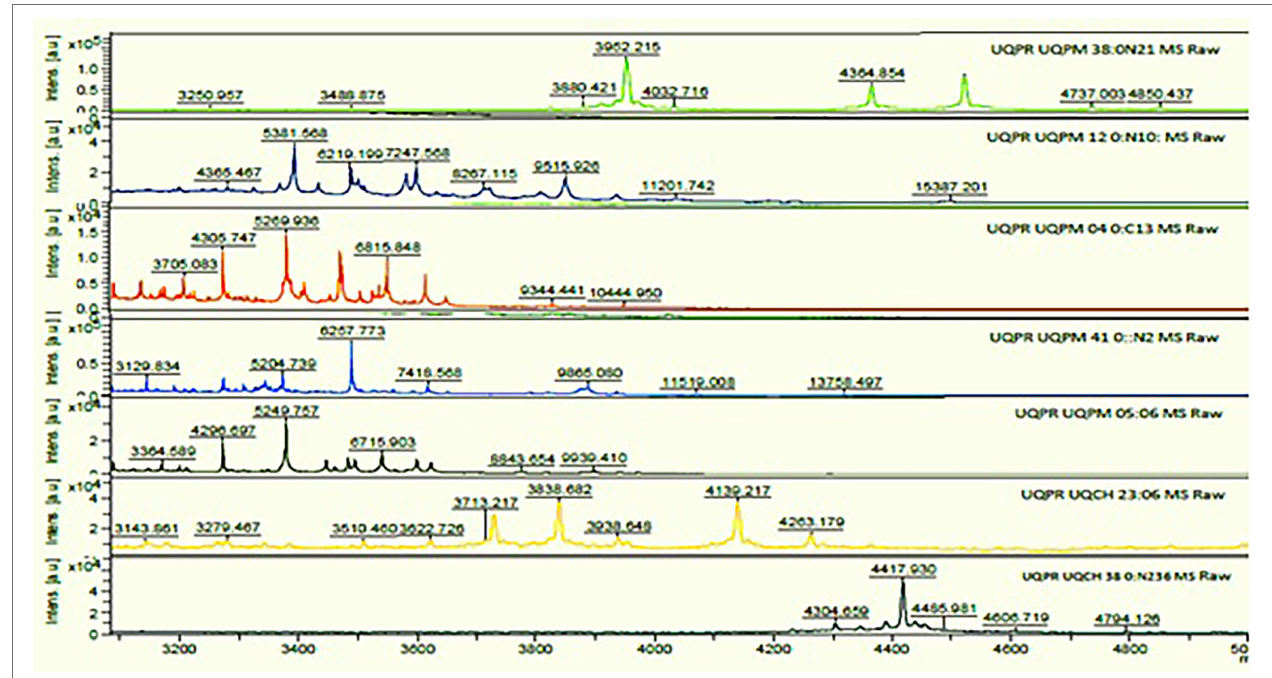
FIGURE 4 | MS spectra of cadmium tolerant isolates on matrix-assisted laser desorption ionization time-of-flight mass spectrometry (MALDI-TOF